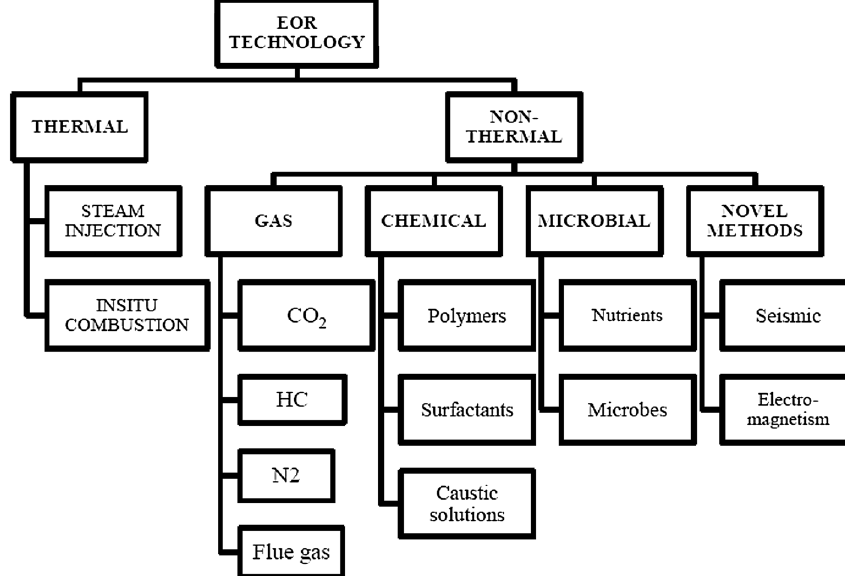
Fig. 1 Classification of EOR